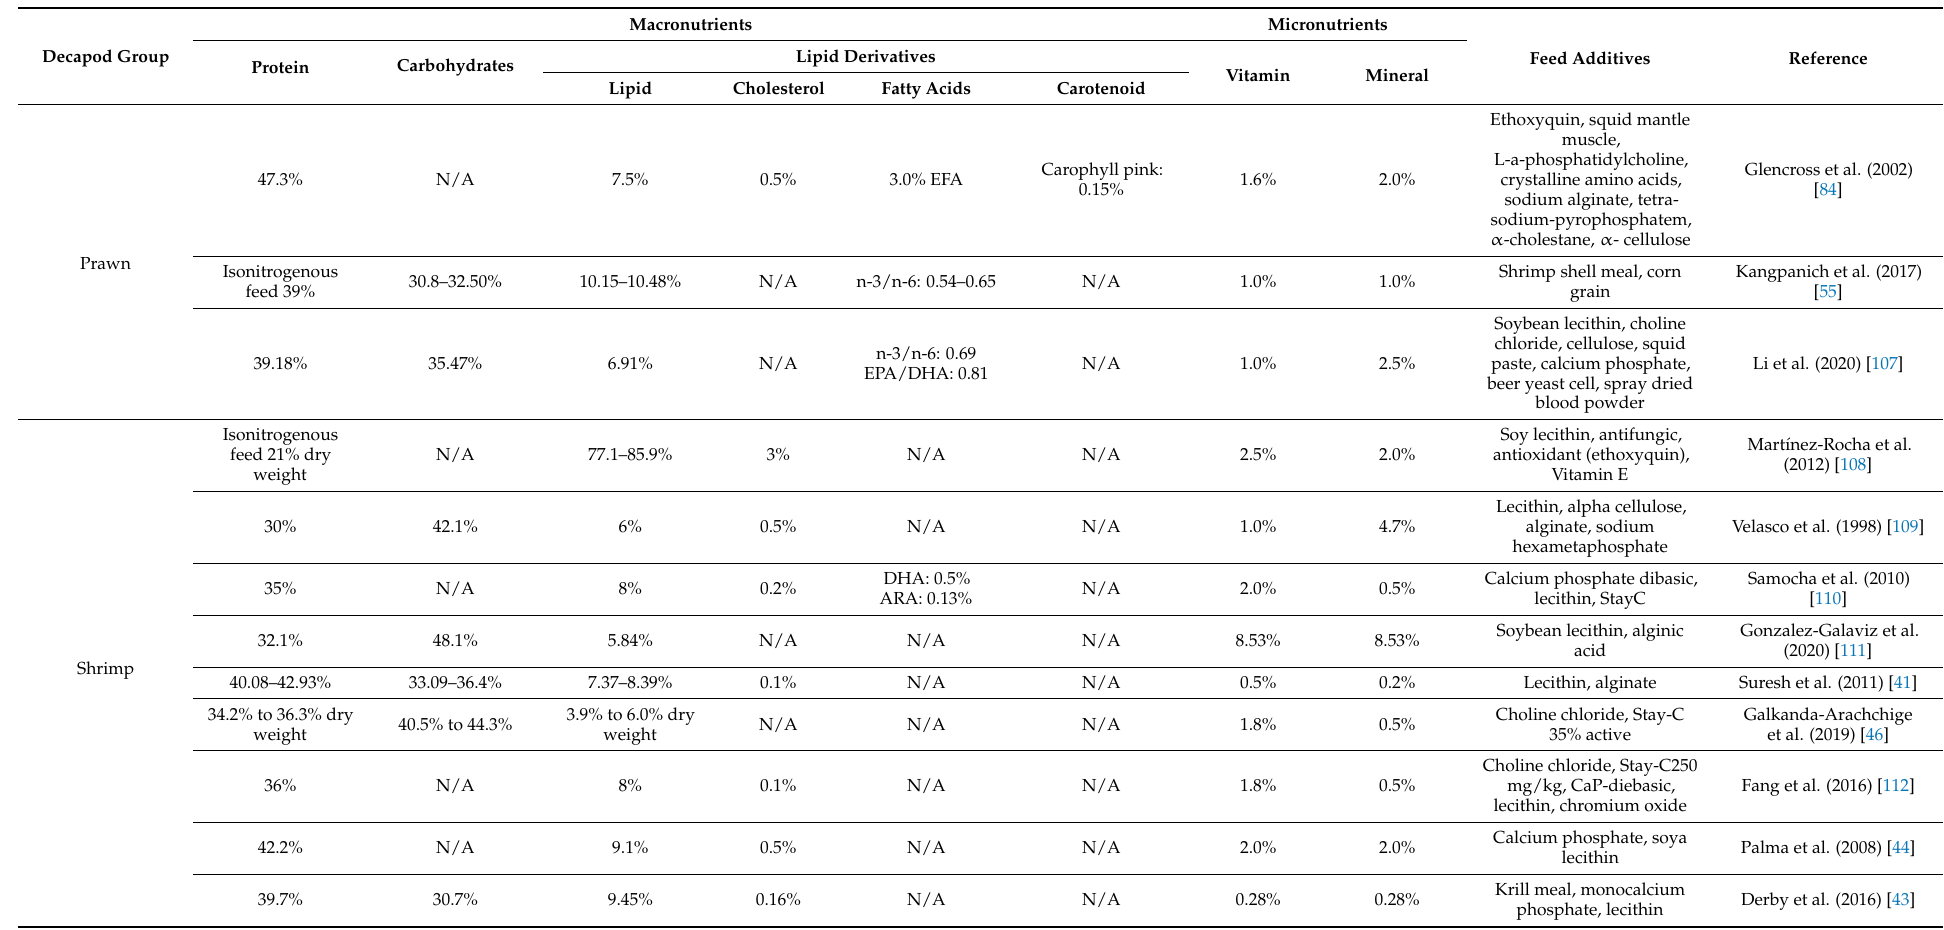
Table 2. Macro and micronutrients in feed formulation of decapods during juvenile